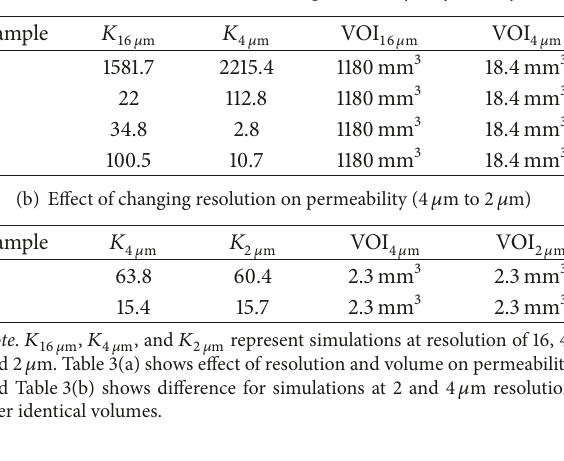
(a) Effect of resolution and volume on permeability (16 𝜇 m to 4 𝜇